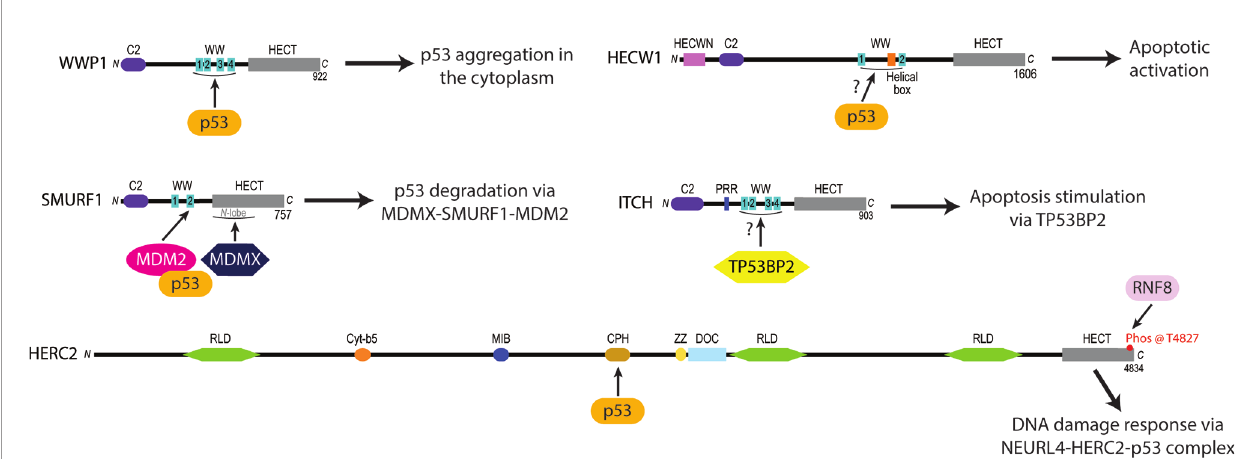
FIGURE 2 | Experimentally identi fi ed p53 protein-protein interaction sites of certain NEDD4L and HERC subfamily HECT E3 ligases linked to oncogenesis. The WW domains of WWP1 are required to recruit p53 and induce its cytoplasmic aggregation (75). HECW1 uses an unknown domain to interact with p53 and upregulate apoptotic cellular activity (149). SMURF1 coordinates the heterodimerization of MDM2 and MDMX via its second WW domain and the N -lobe of its HECT domain to increase the MDM2-dependent K48 polyubiquitylation and subsequent degradation of p53 (78). ITCH is a NEDD4L subfamily E3 ligase that stimulates apoptotic pathways by the WW1-4 domain-dependent activation of Tumor protein p53-binding protein 2 (TP53BP2) (140, 141). HERC2 interacts with p53 through its CPH domain to monitor the p53-MDM2 feedback loop in NEURL4 DDR pathways